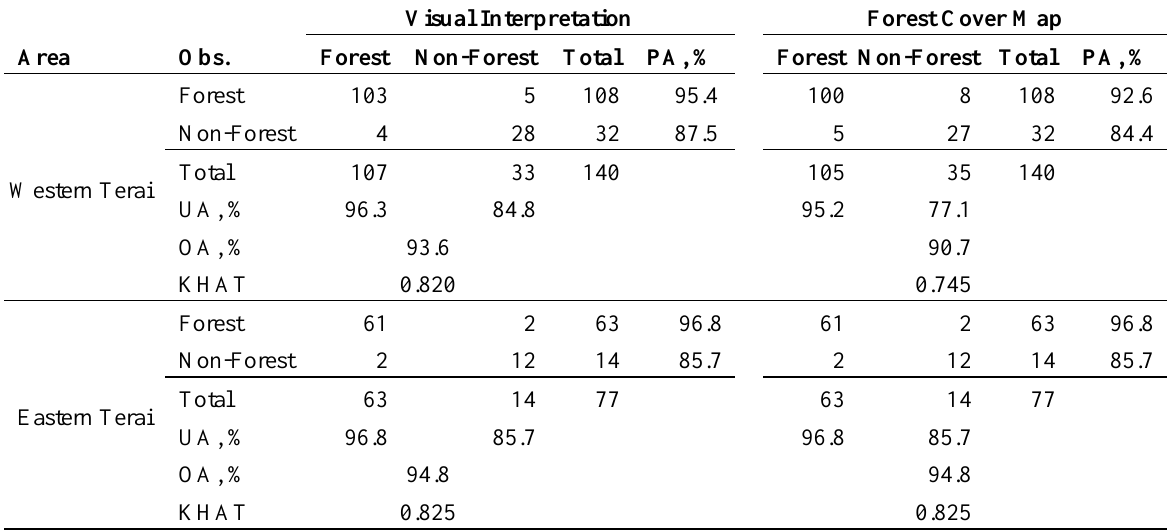
Table 4. Confusion matrices between the forest cover delineations derived from the visual interpretation (Visual), the forest cover map and the field observations (Obs.). (UA = User’s